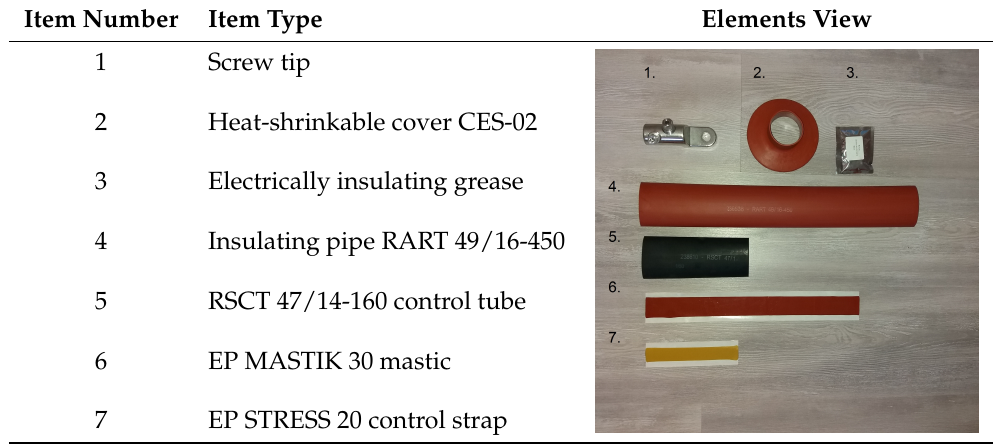
Table 1. Elements of MV cable terminations type